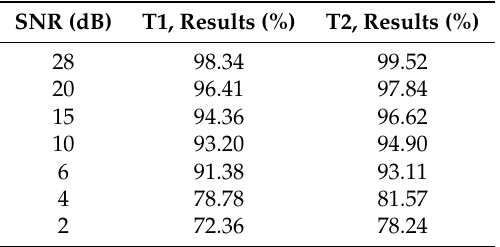
Table 2. Suppression Performance with varied